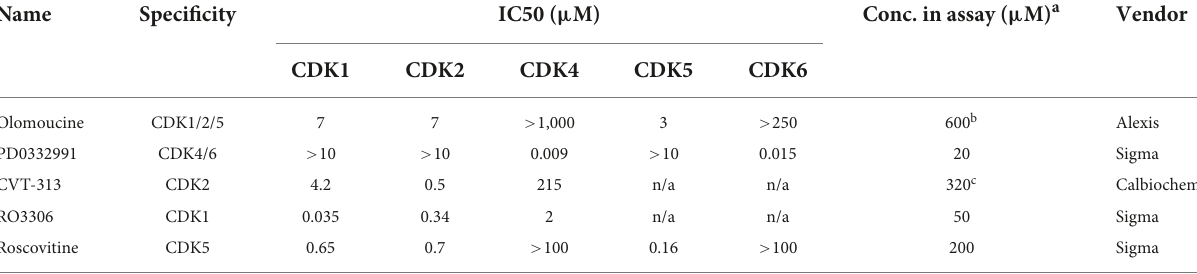
TABLE 1 Pharmaceutical cyclin-dependent kinase (CDK) inhibitors and their